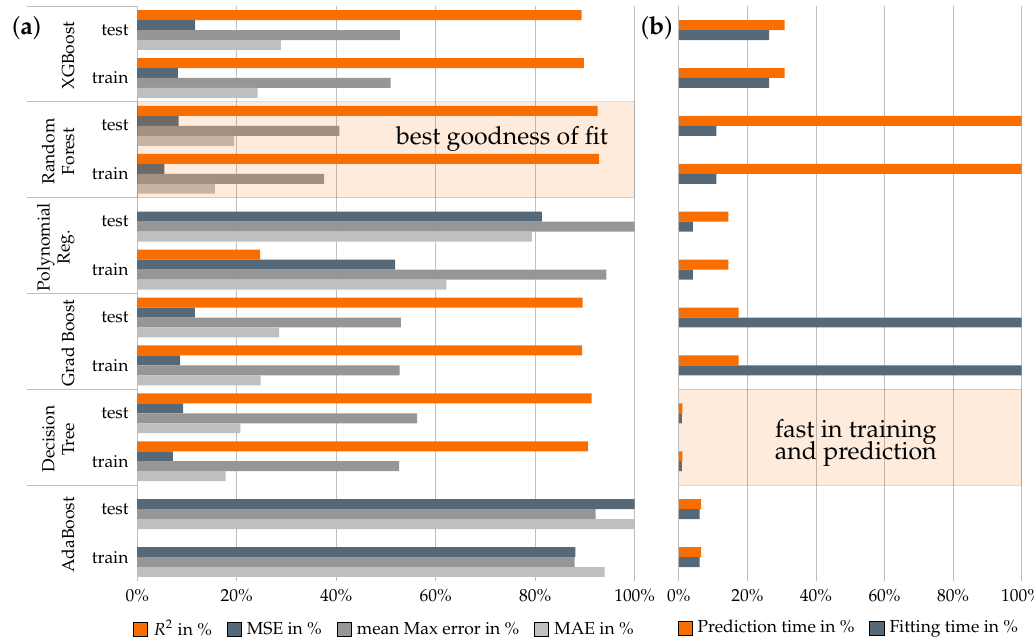
Figure 5. Comparison of model evaluation metrics without outliers for all investigated data-driven approaches for the rib structure: ( a ) Error ( R 2 , mean squared error (MSE), mean MAX error, mean absolute error (MAE)); ( b ) times for training and